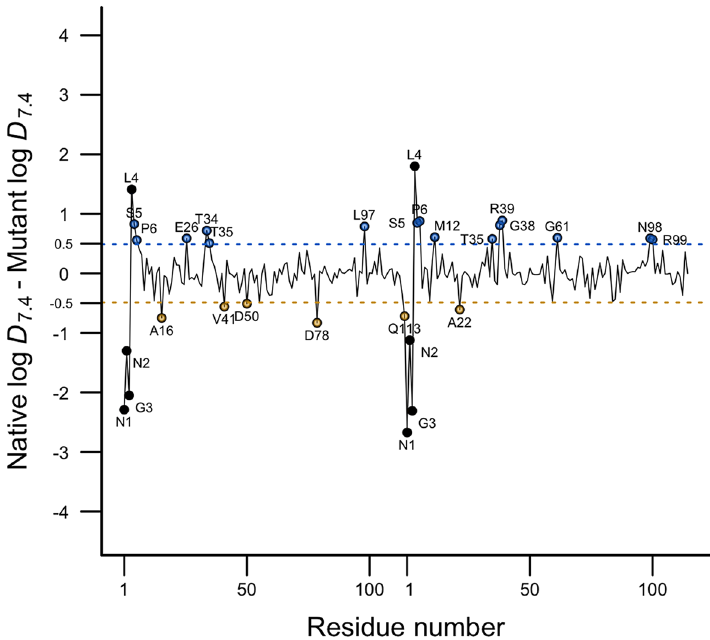
Figure 8. Representation of the difference between cluster-weighted lipophilicities of amino acids in the native form regarding the mutant protein. N-finger residues (black points) and residues whose lipophilicity either decrease (blue points) or increase (yellow points) in the mutant are